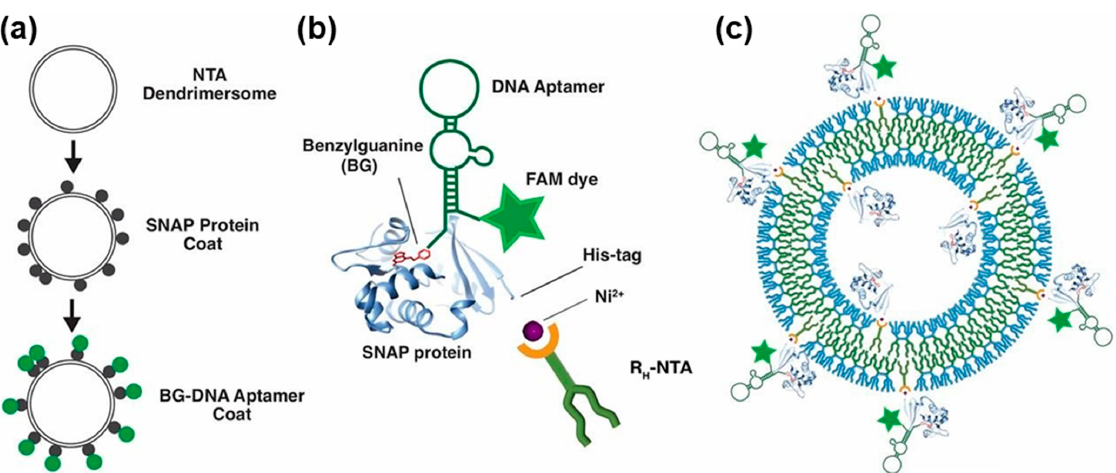
Figure 22. Modular tethering of DNA to SNAP-tagged dendrimersomes. ( a ) Schematic showing layering of a protein and DNA coat to dendrimersome vesicle. ( b ) His-SNAP proteins bind to RH- NTA to form the initial protein layer. SNAP binds to a BG conjugated to the DNA, allowing for the modular formation of a second layer, composed of nucleic acids. The DNA aptamer is labeled with FAM to enable imaging. ( c ) schematic of multilayer dendrimersome containing DNA and protein coat [230]. Copyright (2019) National Academy of Sciences USA.